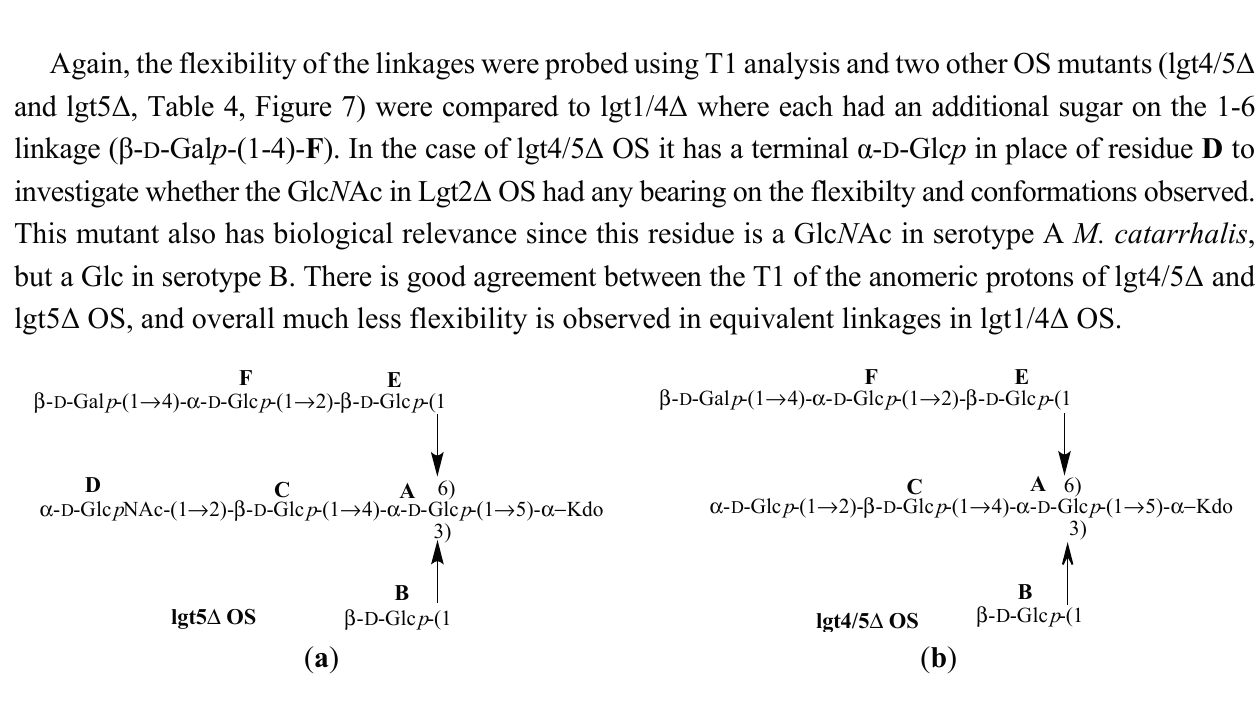
Figure 7. Structures of Moraxella catarrhalis serotype A (strain 2951) ( a ) lgt5 Δ OS [14] and ( b ) lgt4/5 Δ OS